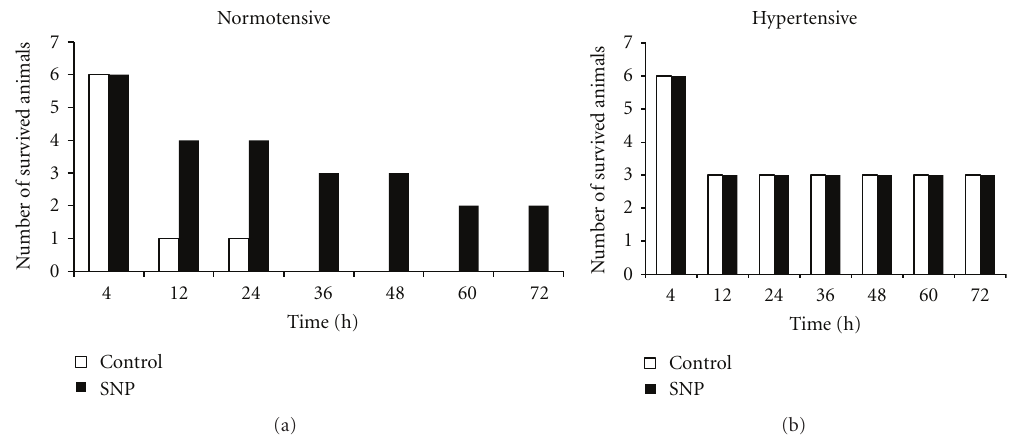
Figure 4: Comparison of survival rate in normotensive and hypertensive animals in SNP-treated and control